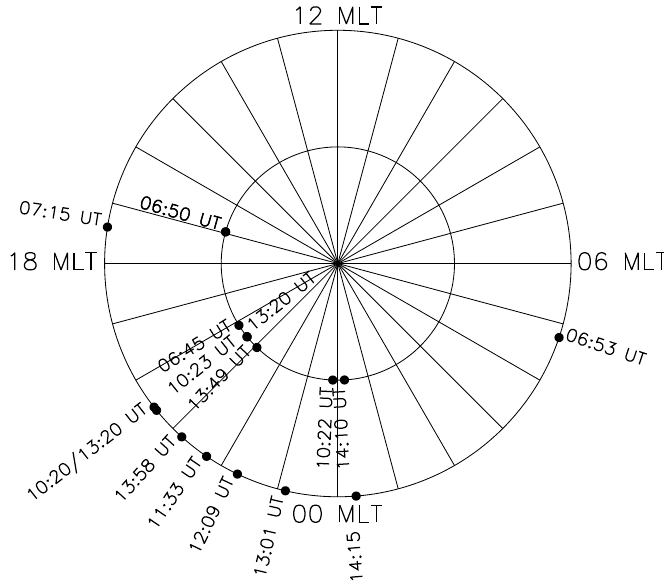
Fig. 3. The universal time (UT) and magnetic local time (MLT) of ion flux decreases (inner circle) and electron flux decreases (outer circle) measured on board the LANL geosynchronous satellites dur- ing the evening of 30 November 2002. These timings are also listed in Table